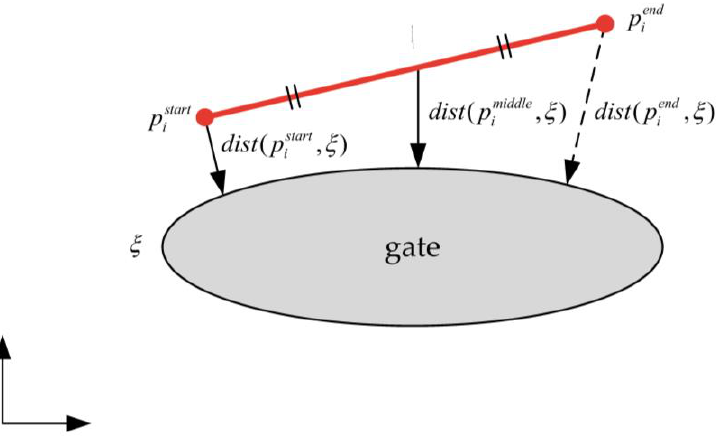
Figure 5. Merging of similar line segments.